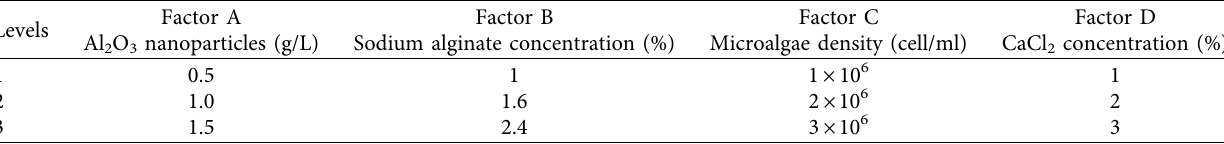
Table 1: Factors and levels of the orthogonal experiment